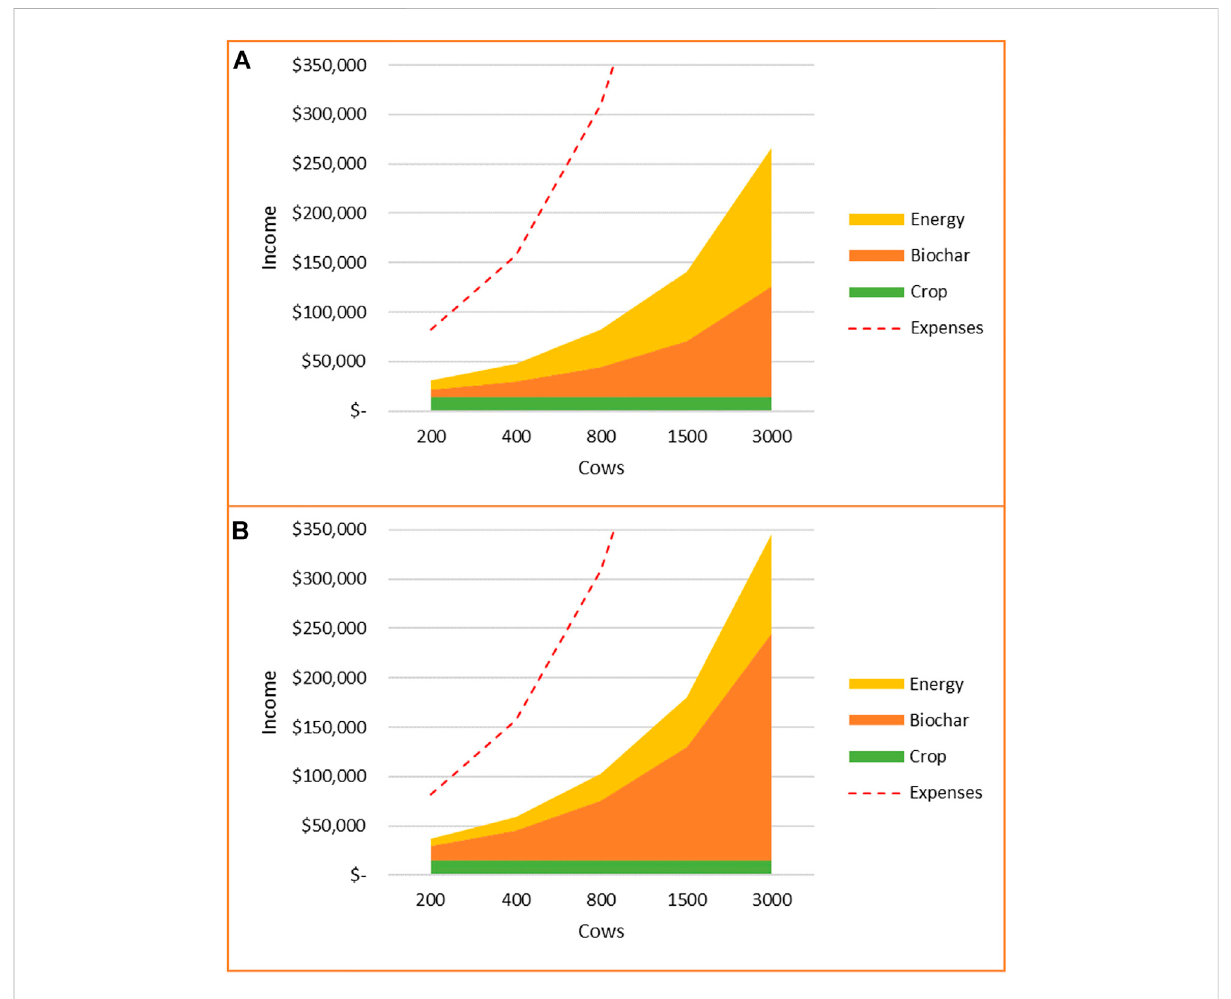
FIGURE 6 Components of Monthly Income [dairy omitted] Using Gasi fi cation (A) and Pyrolysis (B)